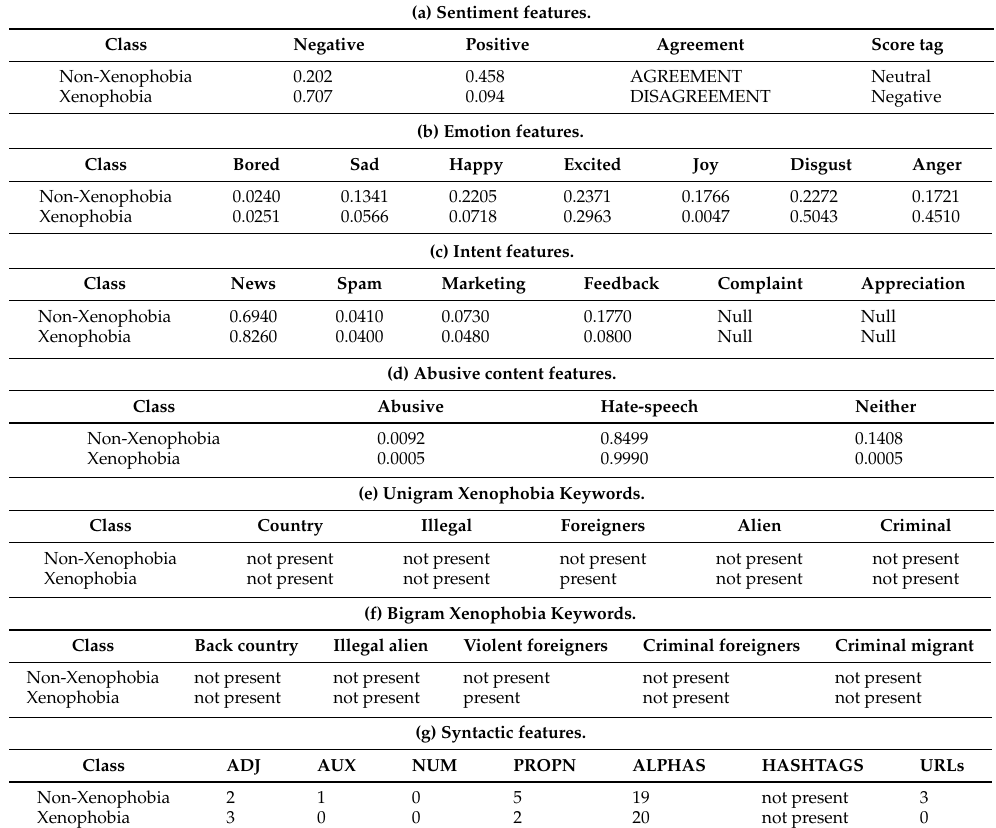
Table 6. Example of our interpretable feature representation for tweets belonging to the Xenophobia and non-Xenophobia class grouped by different key labels. (a) Sentiment features.